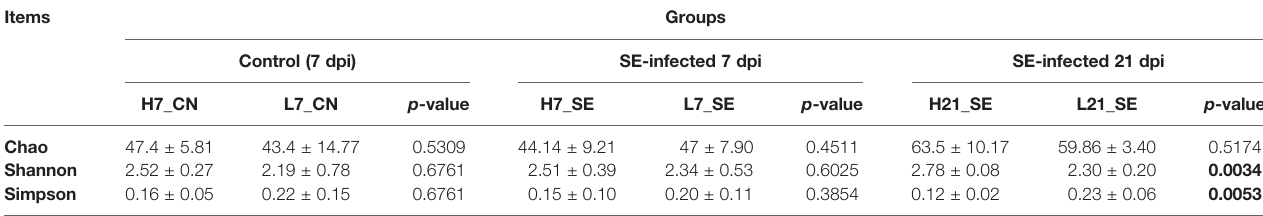
TABLE 2 | Alpha diversity (genus level) of cecal microbiota of Control (7dpi) and SE-infected (7 and 21 dpi) High and Low H/L ratio chicken groups. Items Groups